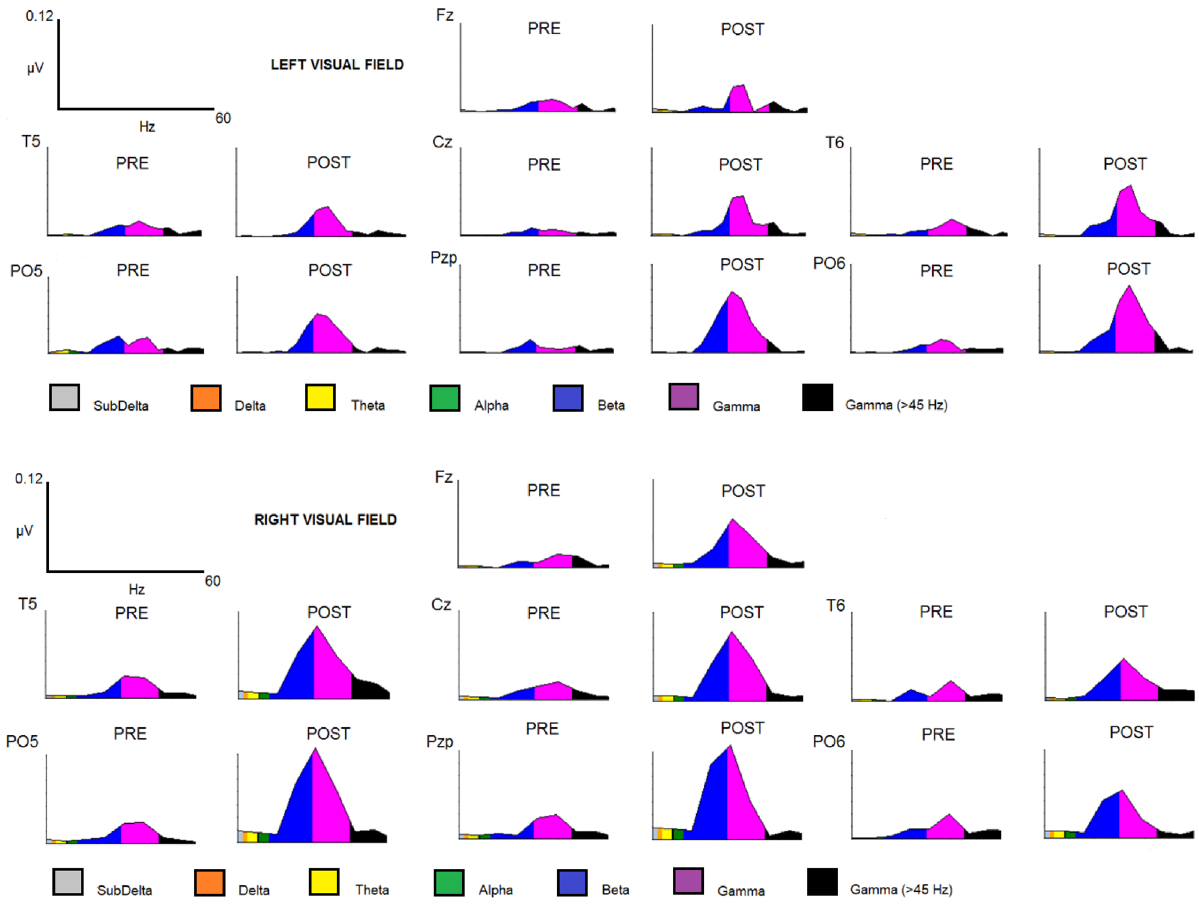
Figure 3. FFT power spectrum for the LVF and RVF